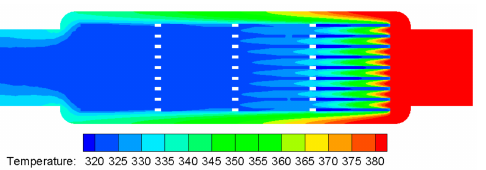
Figure 6. XY plane contours of two-pass water-cooled charge air cooler (K).